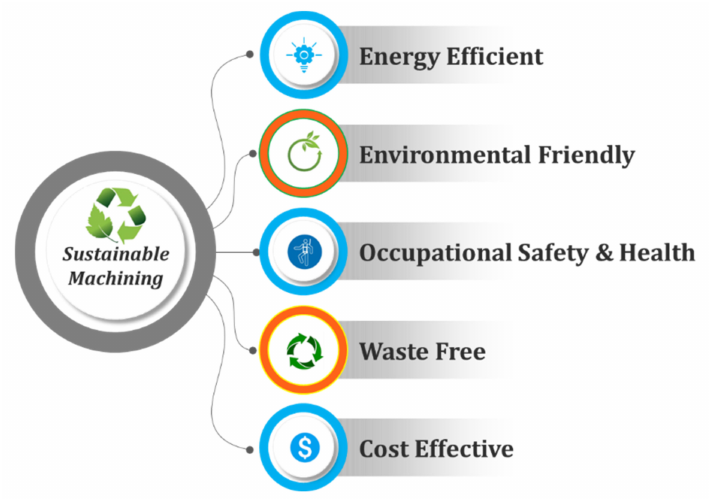
Figure 5. Characteristics of Sustainable machining, reprinted with permission from ref. [17]. Copy- right 2010 CIRP, Published by Elsevier